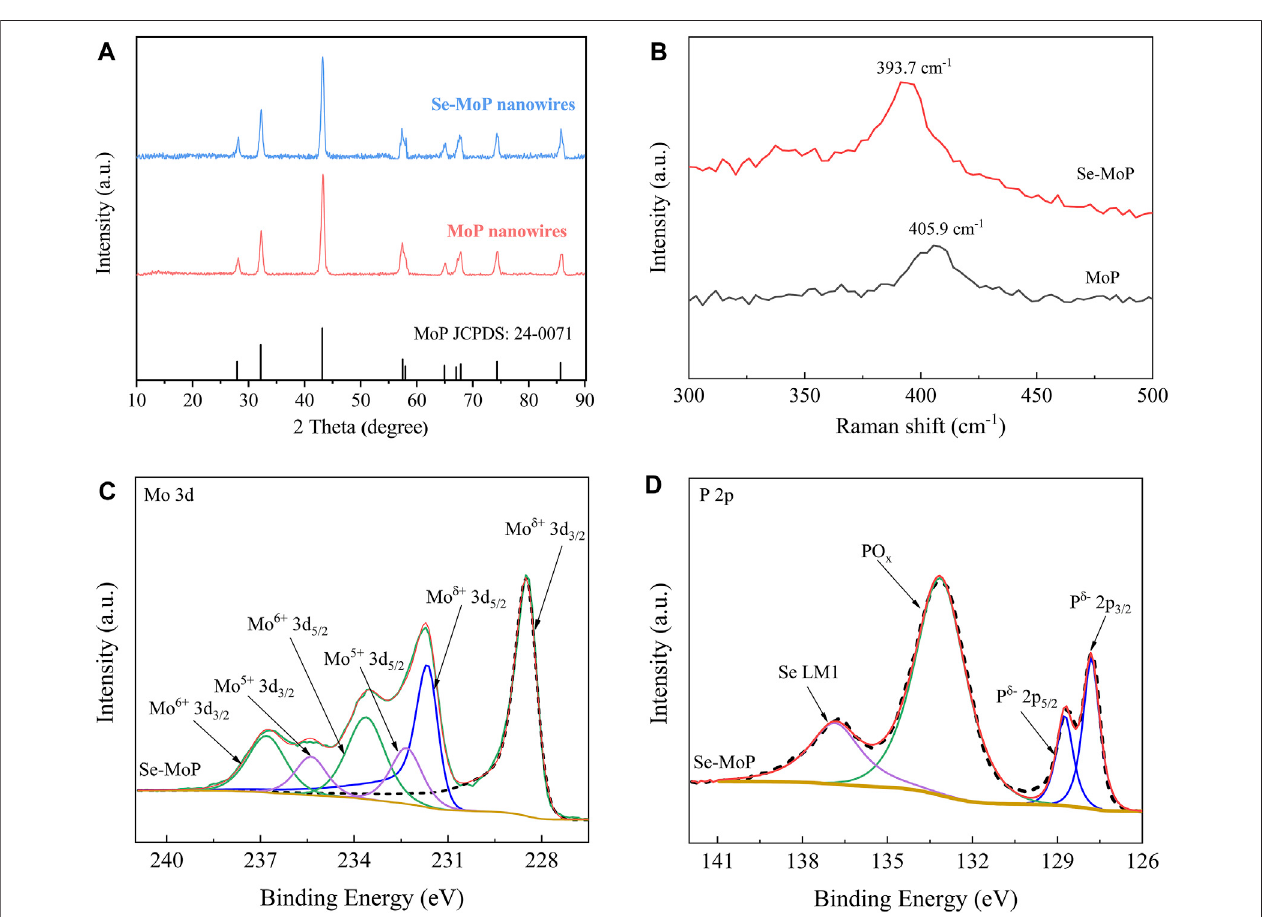
FIGURE 2 | (A) XRD patterns, (B) Raman spectra, (C) high-resolution XPS spectra of Mo 3 days, and (D) P 2p of Se-MoP nanowires.